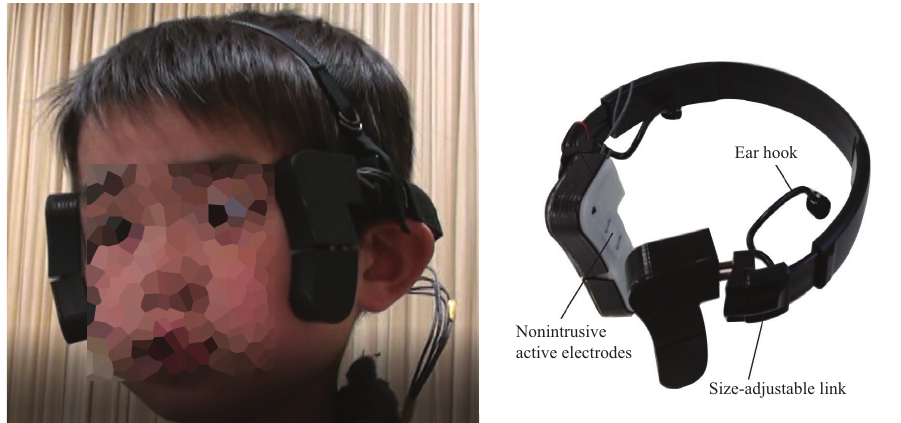
Figure 2. The participant wearing the wearable